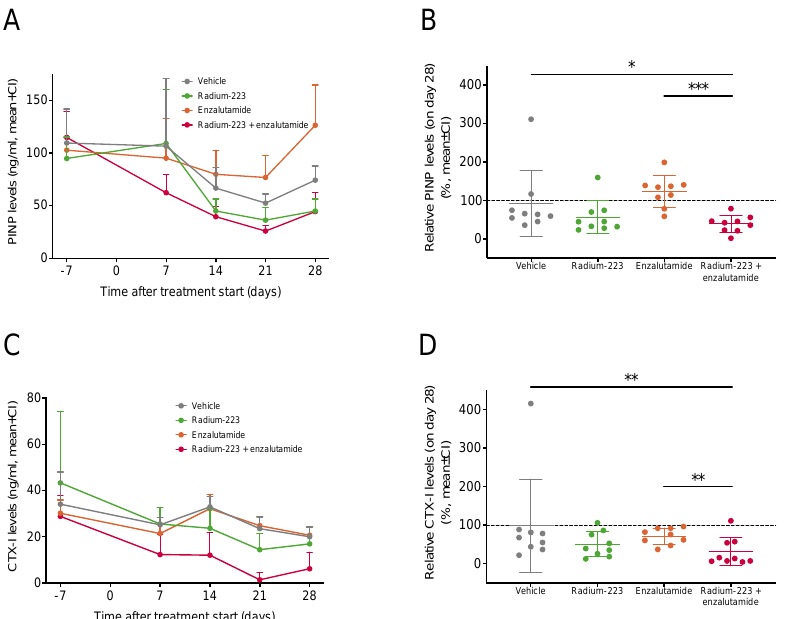
Figure 4. Radium-223 and enzalutamide combination treatment inhibits abnormal bone turnover. ( A , B ) PINP and ( C , D ) CTX-I bone marker levels were measured in blood samples collected from the saphenous vein of mice ( n = 9/group) 7 days prior to and 7, 14, 21, and 28 days after the initiation of treatment. The mice were treated with vehicle, radium-223 (330 kBq/kg, Q4W × 2), enzalutamide (30 mg/kg, QD, p.o.) or the combination of radium-223 and enzalutamide. Values describe mean and 95% confidence interval (CI). The statistical analyses were performed using mixed models and model contrasts: * p < 0.05; ** p < 0.01; *** p <